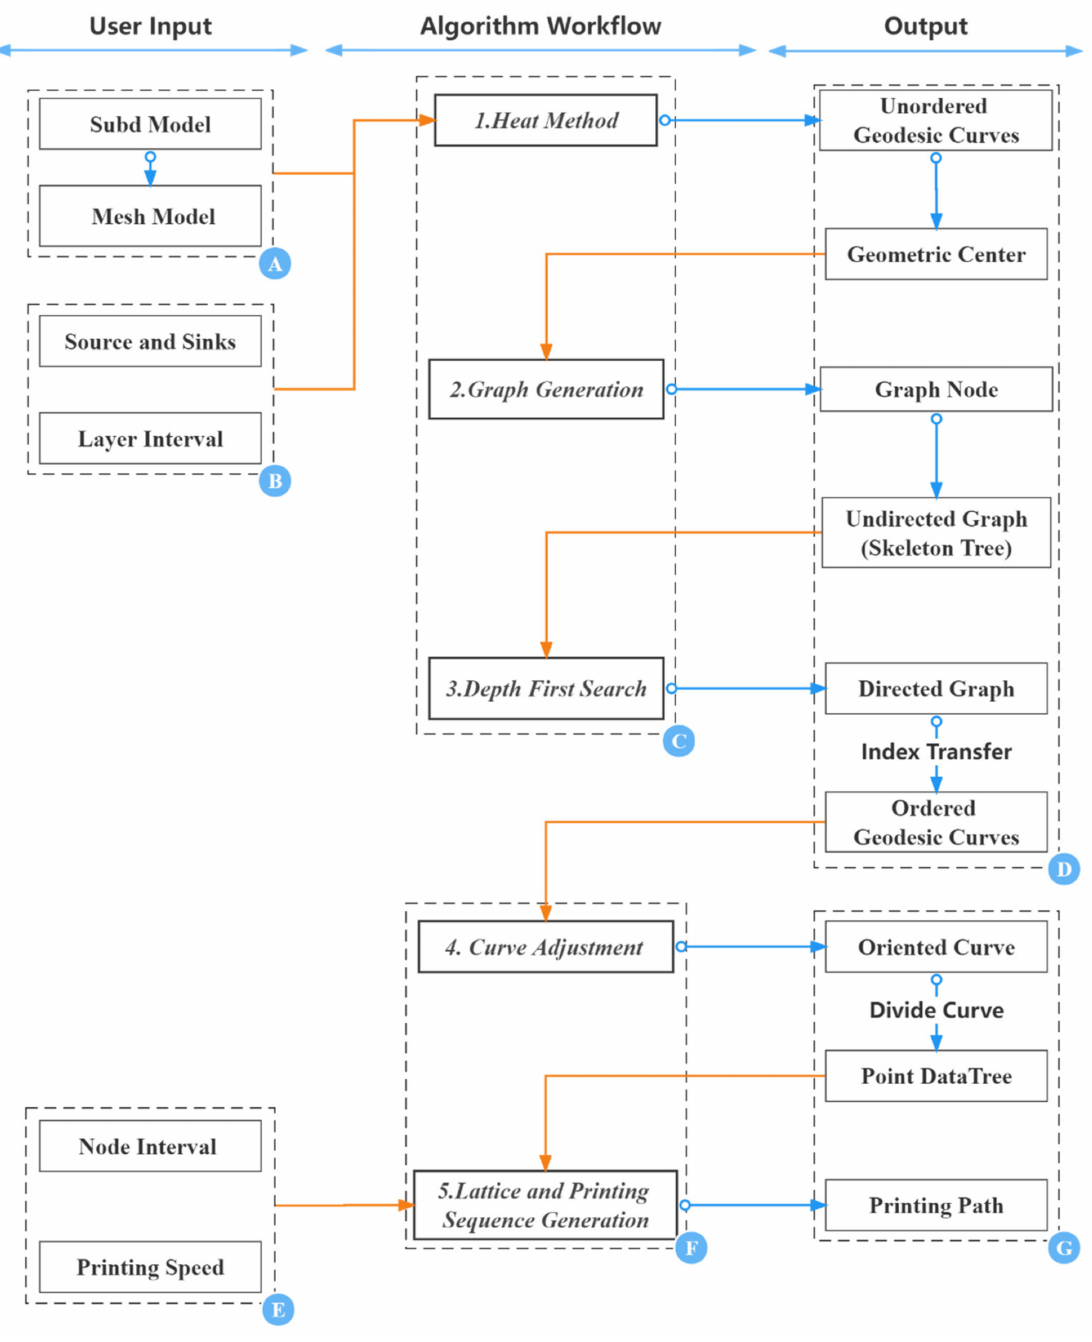
Figure 3. Overview of the